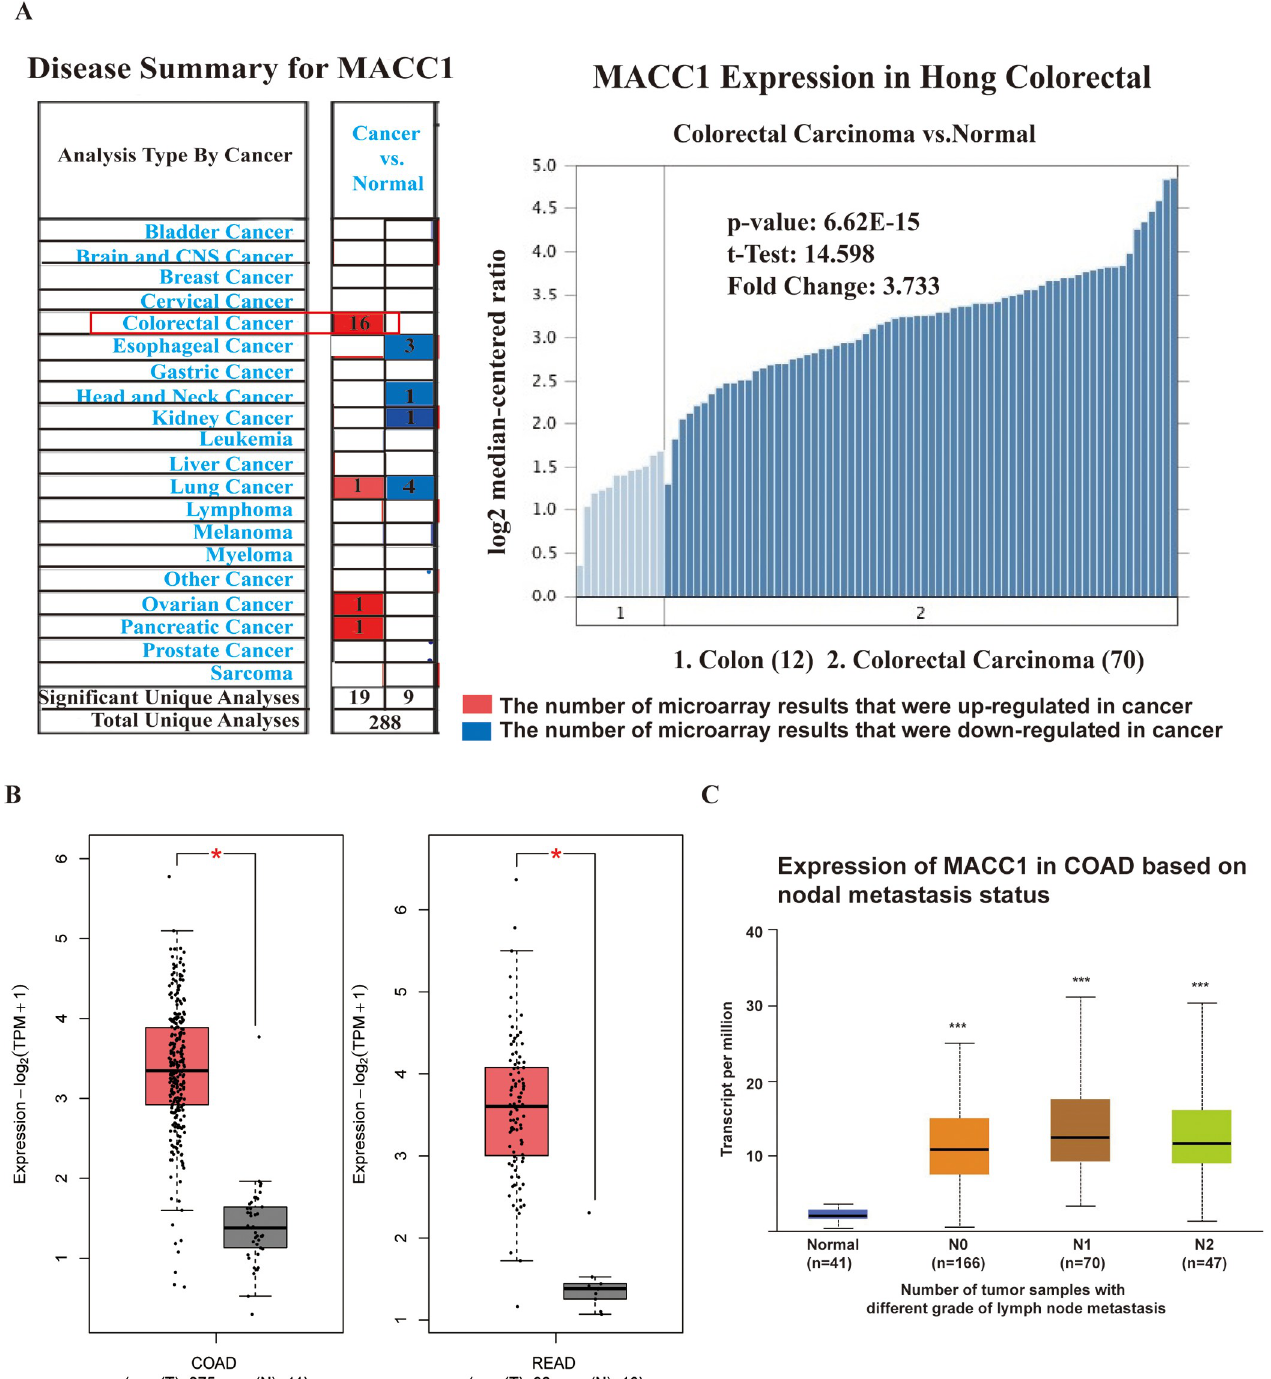
Fig 2. Expression levels of MACC1 mRNA in CRC tissues. (A) Expression levels of MACC1 mRNA in CRC tissues and normal tissues from Oncomine databse. Red box represents the number of microarray results that were up-regulated in colorectal cancer. Blue box represents the number of microarray results that were down-regulated in colorectal cancer.The graph on the right is the results from Hong Colorectal dataset. The results showed that MACC1 expression was up-regulated 3.733-fold in CRC specimens compared with control colon tissue specimens. (B) Expression levels of MACC1 mRNA in CRC tissues and normal tissues from GEPIA 2 database. Red represents the expression in tumor tissue and gray represents the expression in normal tissue. � p < 0.05. (C) Expression levels of MACC1 mRNA with lymphatic metastasis CRC tissues and non-lymphatic metastasis control tissues in UALCAN database. The abscissa represents the number of tumor samples with different grade of lymph node metastasis. ��� p < 0.001.